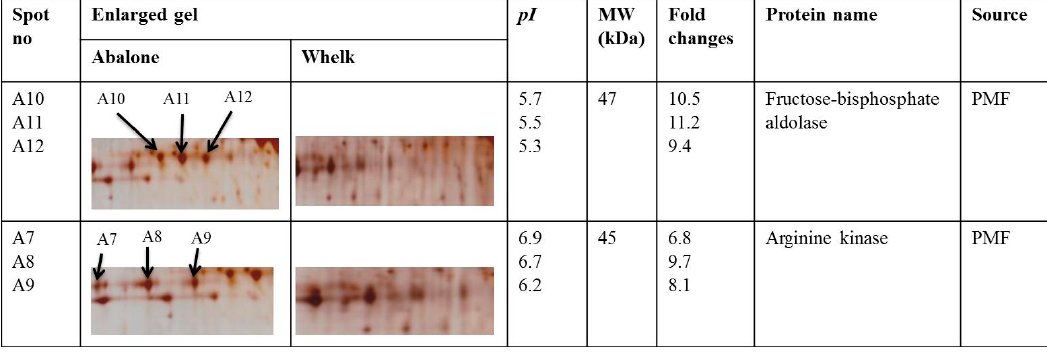
Figure 6. Differentially expressed protein spots identified successfully by matrix-assisted laser desorption/ionisation time-of-flight mass spectrometry (MALDI-TOF/TOF MS).